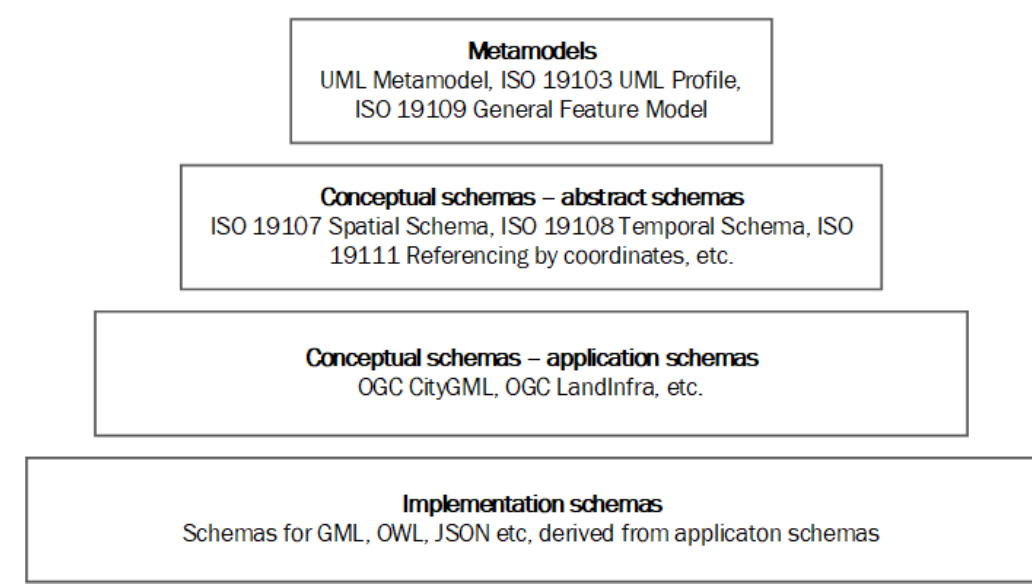
Figure 11. ISO 19103 MDA Levels of abstraction. Adapted from [60].